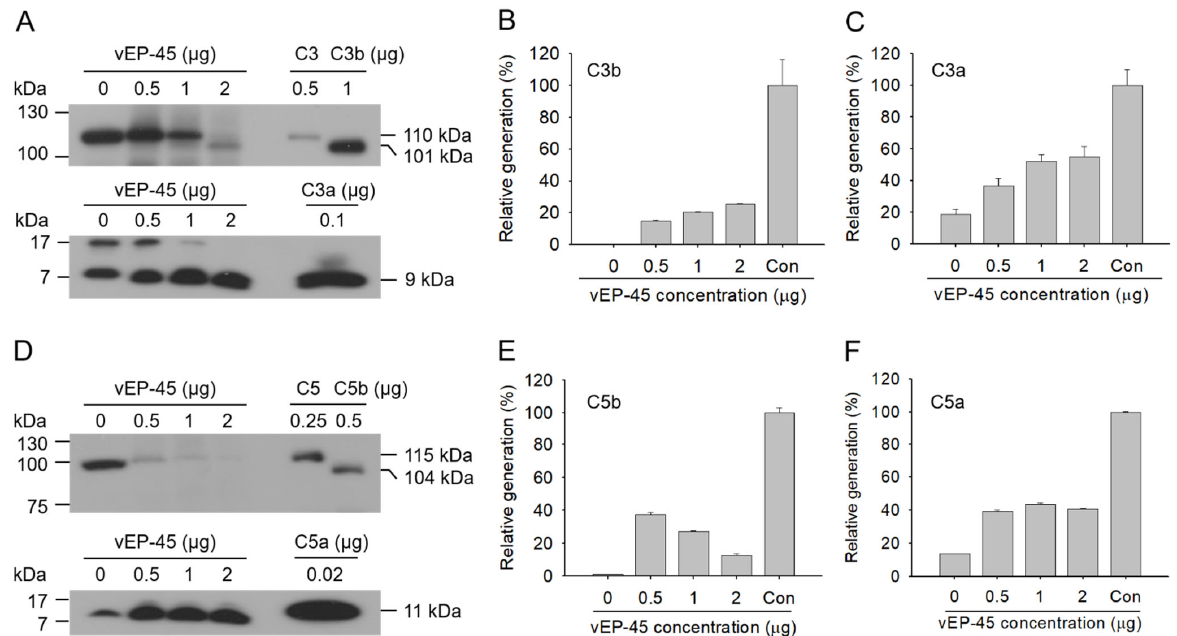
Figure 3. Cleavage of C3 and C5 by vEP-45 in human plasma. ( A , D ) Samples of human blood plasma (10%) were incubated with vEP-45 (0.5, 1, or 2 µ g) for 3 min at 37 ◦ C. Proteins from each sample were separated by SDS-PAGE; Western blotting was performed using anti-C3 antibody ( A upper panel), anti-C3a antibody ( A lower panel), anti-C5 antibody ( D upper panel), or anti-C5a antibody ( D lower panel). The histograms show the production of ( B ) C3b α (cid:48) chain, ( C ) C3a, ( E ) C5b α (cid:48) chain, and ( F ) C5a upon treatment with different concentrations of vEP-45, in which the values obtained from a control (Con; only C3b, C3a, C5b, and C5a) were considered as 100%. The uncropped Western Blot images can be found in Figure